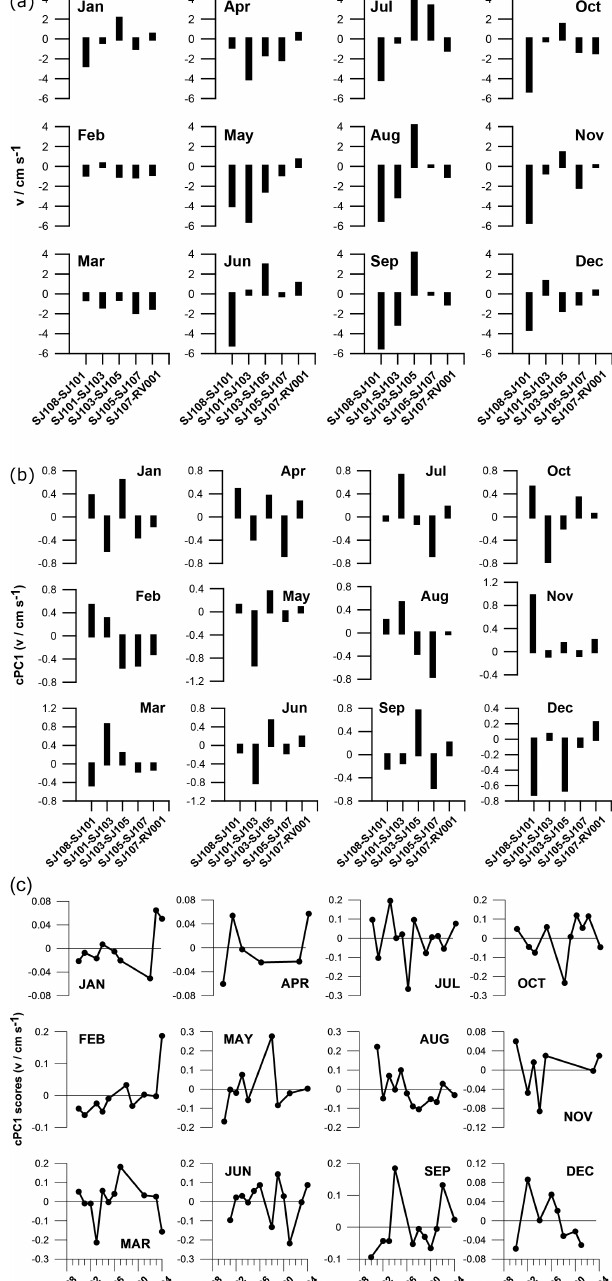
Figure 2. Monthly averages (a) , cPC1 loadings (b) and cPC1 scores (c) of geostrophic currents relative to 30dbar between stations of the Po River delta–Rovinj profile for the 1990–2004 period.